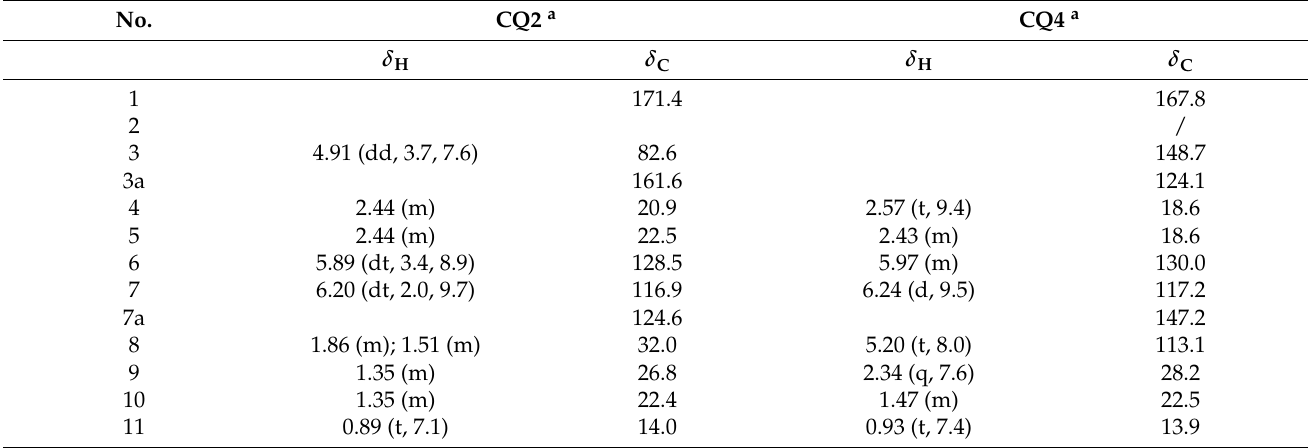
Table 7. 1 H and 13 C NMR data of CQ2 and CQ4 (CDCl 3 , δ in ppm, J in Hz).